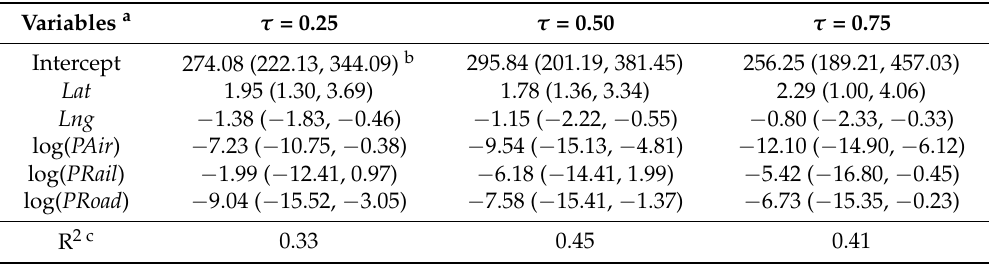
Table 3. Multivariate quantile regression showing the associations between the 0.25, 0.50, and 0.75 quantiles of arrival days and passenger volumes of three transport modes in 115 prefectures.